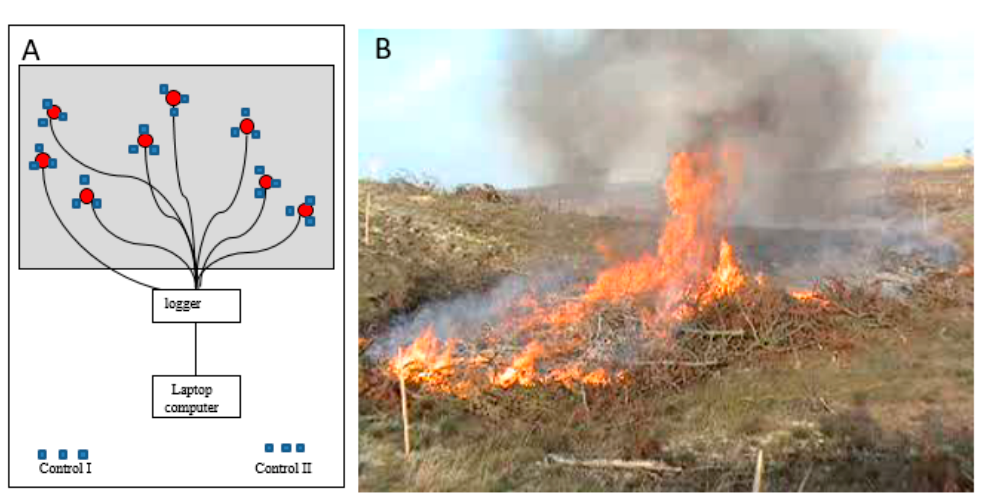
Figure 1. ( A ). Illustration of the set-up of an experiment seen from above. The grey area is where the